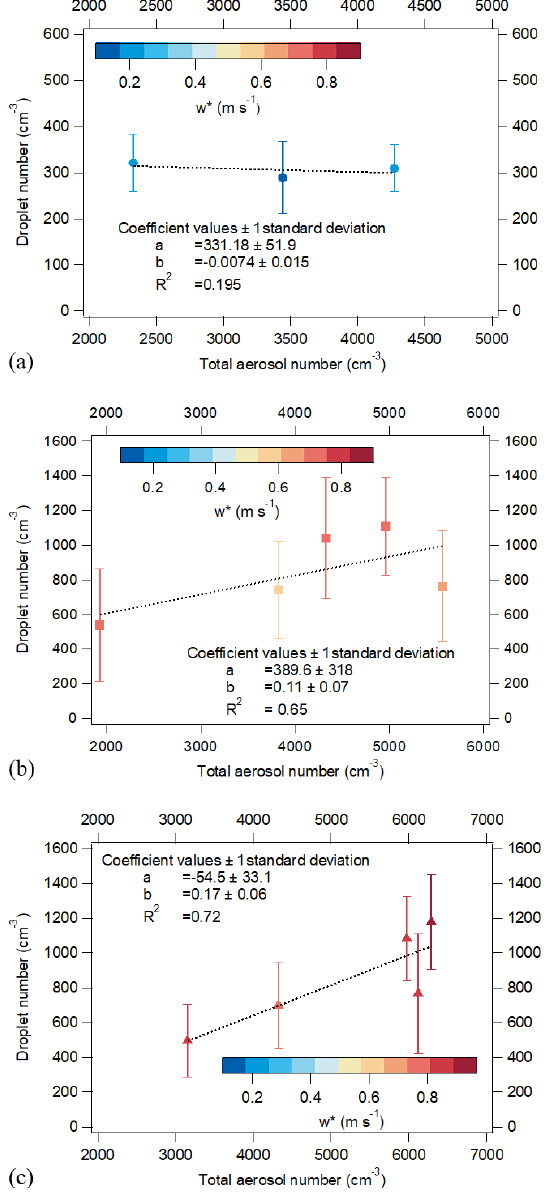
Figure 5. Average cloud droplet number vs. total aerosol number, colored by characteristic velocity w ∗ for each flight. Error bars rep- resent the standard deviation of cloud droplet number during each flight.